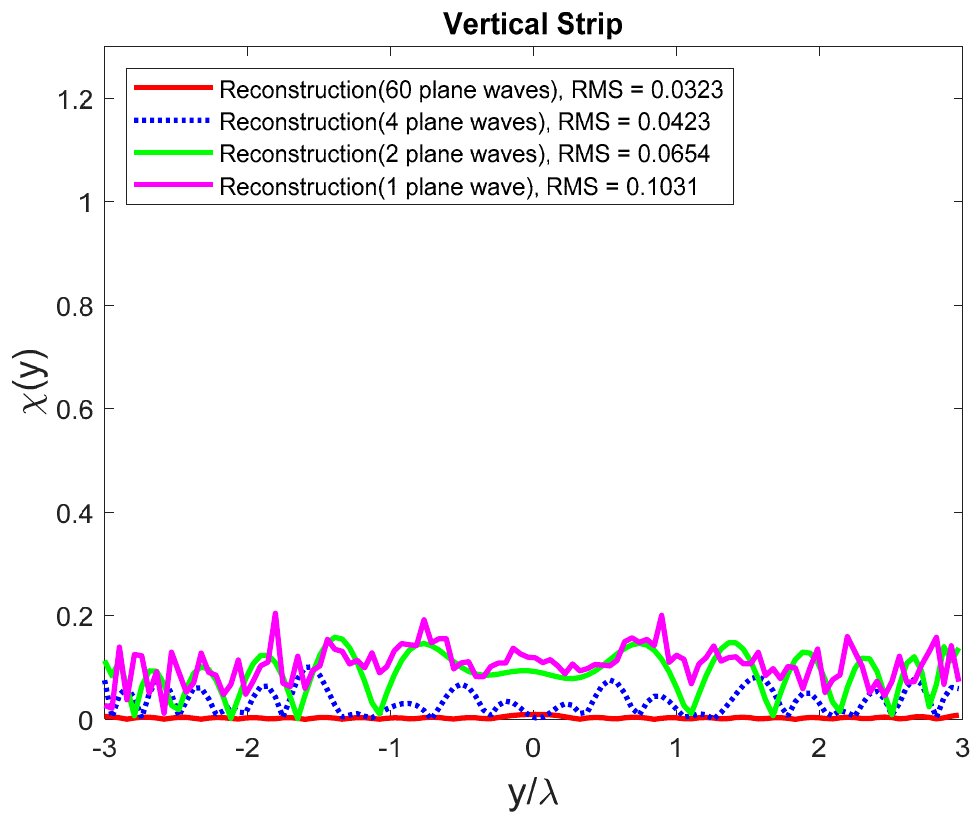
Figure 15. The influence of the reconstruction of the object of Figure 14 on the vertical strip ID .